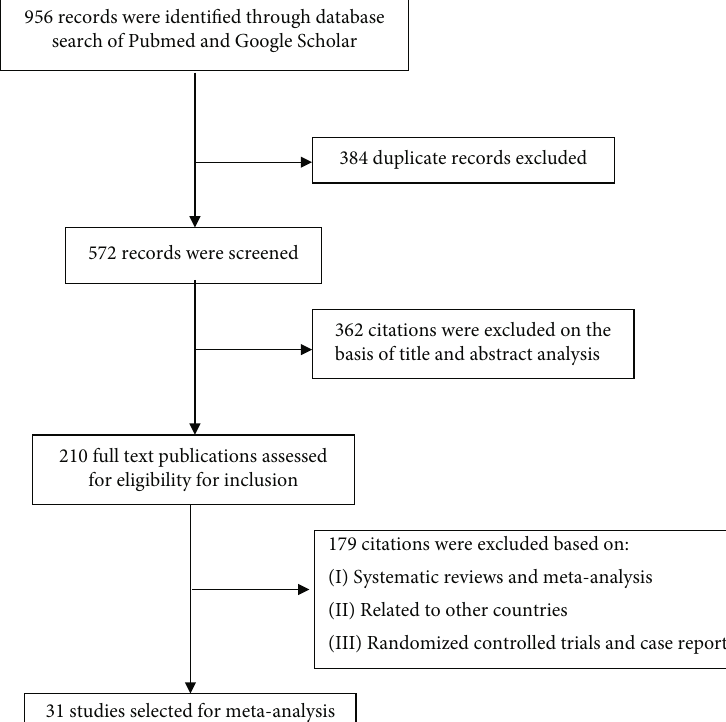
Figure 1: Flowchart for study